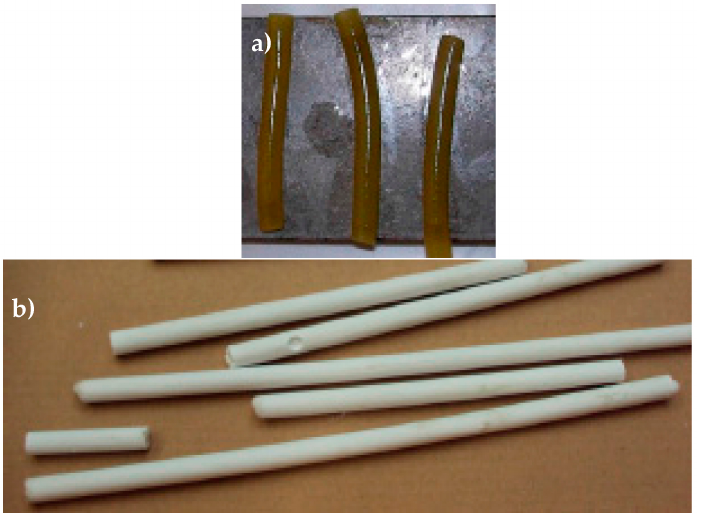
Figure 15. ( a ) Starch-based capsules are coated with a water-repellent spray; and ( b ) IPC tubes after curing.